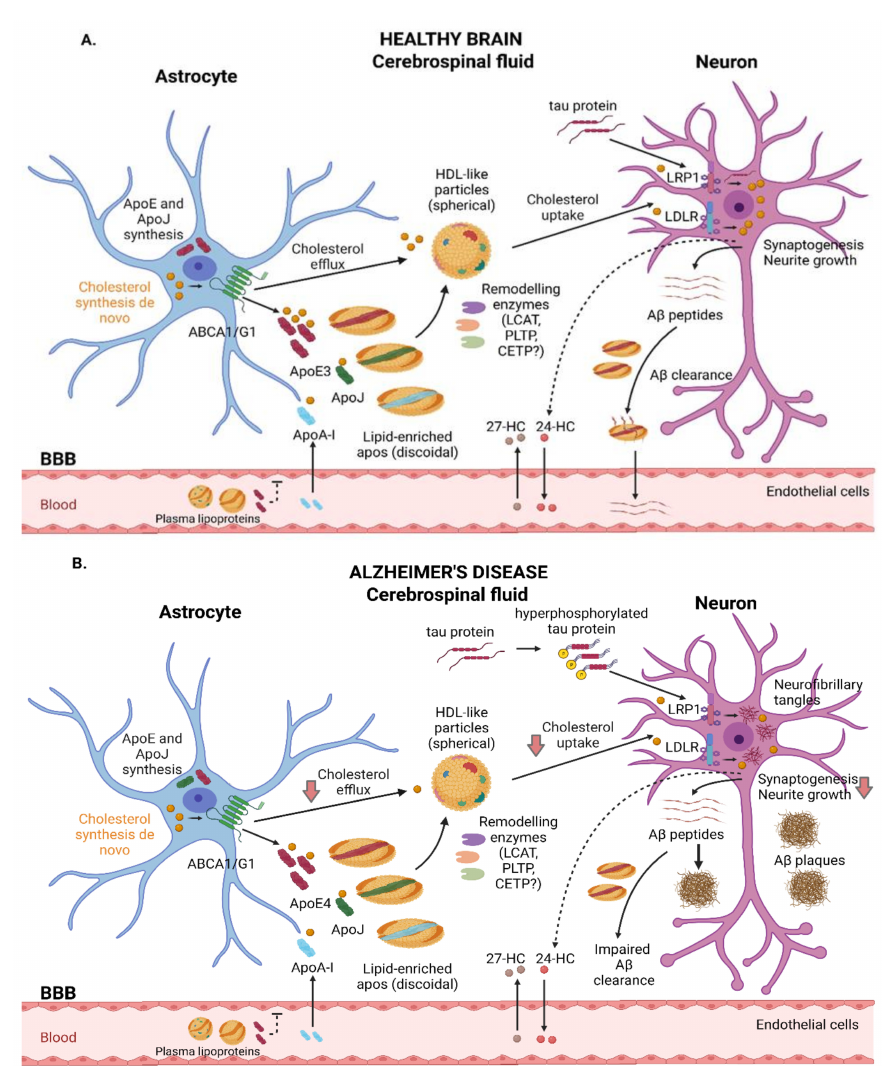
Figure 1. Schematic representation of the main steps involved in cholesterol trafficking in the brain. ( A ) In healthy subjects, astrocytes are responsible for de novo cholesterol and ApoE synthesis, with ApoE3 being the predominant isoform. Cholesterol efflux from astrocytes occurs, in part, through the ABCA1 and ABCG1 transporters. Lipid-free ApoE and, in smaller amounts, ApoA-I and ApoJ can be further lipidized by remodeling enzymes, resulting in spherical mature HDL-like particles that can interact with membrane receptors such as LRP1 and LDLR, leading to cholesterol uptake by neurons and guaranteeing essential functions such as synaptogenesis and neurite growth. Oxysterols can flux across the BBB. Neurons convert excess cholesterol in 24-HC, which can be eliminated to the bloodstream. In contrast, 27-HC enters the brain, where it promotes various functions. ApoE also contributes to the clearance of A β peptides. ( B ) In AD subjects, the pathological accumulation of hyperphosphorylated tau protein and A β plaque deposition may alter physiological functions in the brain. ApoE4, the predominant isoform in AD patients, is poorly lipidated and barely removes A β peptides. LRP1 plays a critical role in neuronal tau endocytosis. Recent works suggest alterations regarding cholesterol transport, including reduced HDL-like-mediated cholesterol efflux and impaired cholesterol uptake, leading to cell dysfunction. ABC: ATP-binding cassette; AD: Alzheimer’s disease; Apo: apolipoprotein; A β : amyloid beta; BBB: blood–brain barrier; CETP: cholesteryl ester transfer protein; HC: hydroxycholesterol; HDL: high-density lipoprotein; LCAT: lecithin-cholesterol acyltransferase; LDLR: low-density lipoprotein receptor; LRP1: LDLR-related protein